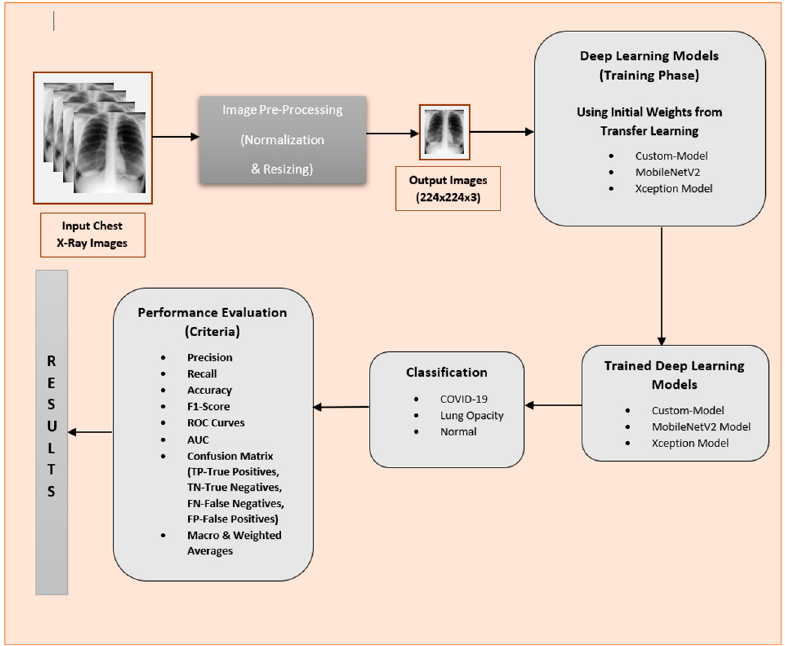
Figure 2. Overall system architecture.